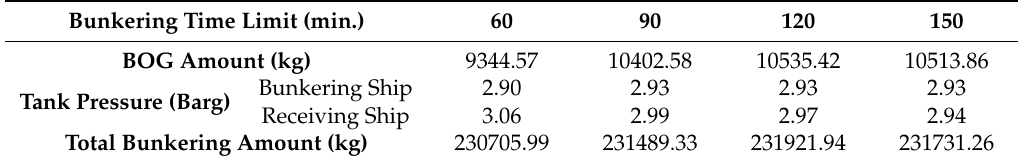
Table 5. Quantity of state respect to different bunkering time limits (Finish Bunkering).